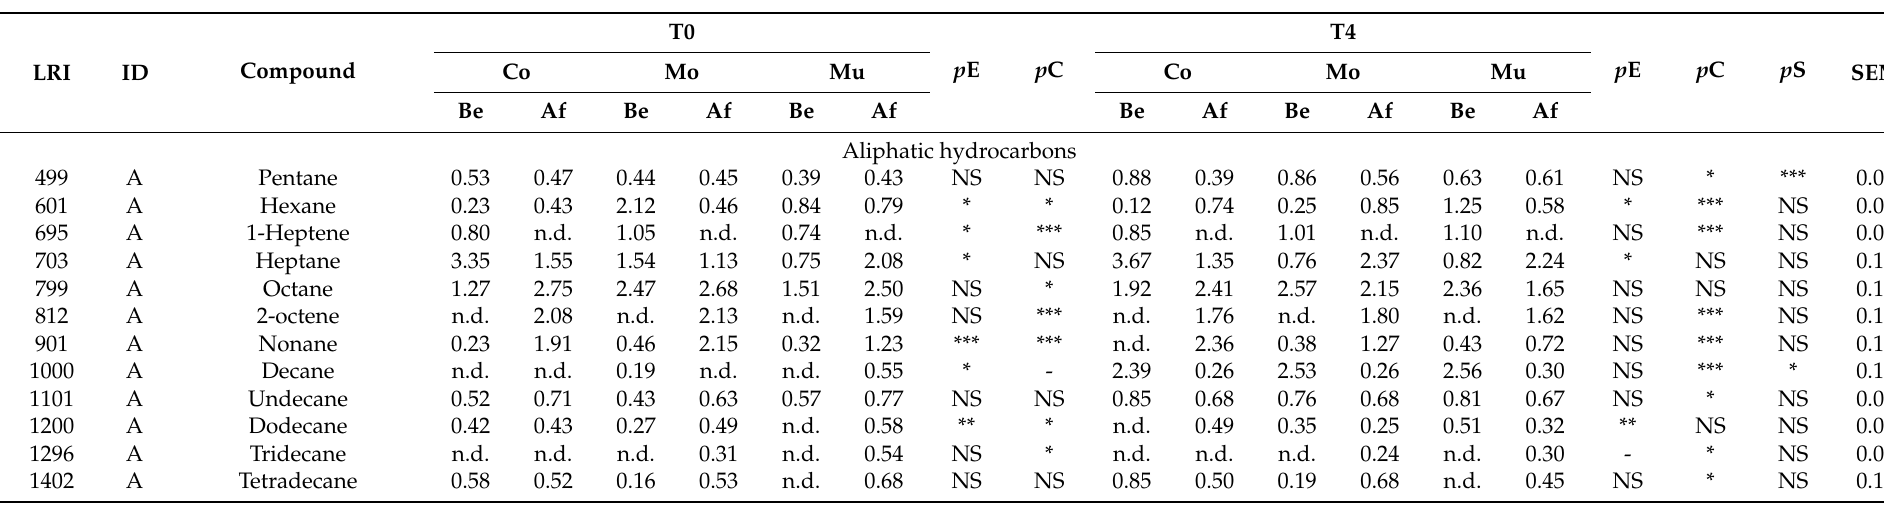
Table 2. Storage (pS) and culinary heating (pC) effects on the abundance of volatile compounds (AU × 10 6 ) in omega-3-enriched cooked sausages